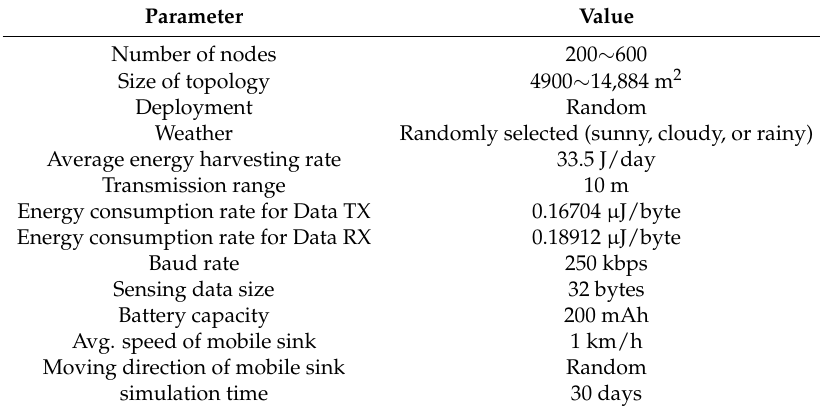
Table 3. Experimental environments.